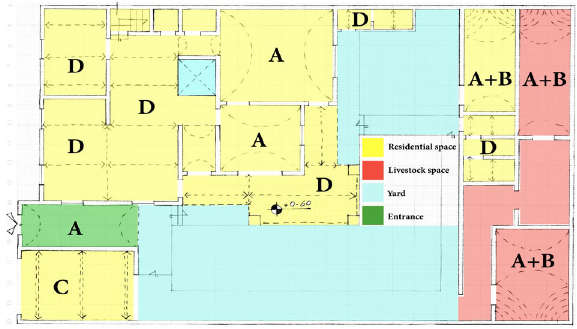
Figure 18. One example of houses in the fourth era, houses in this period are usually a combination of several modes of construction, some over time, (A: Barrel vault, B: Chahar-dori vault, C: Takhte-Poosh, D: Girder and Zarbi vault), author.